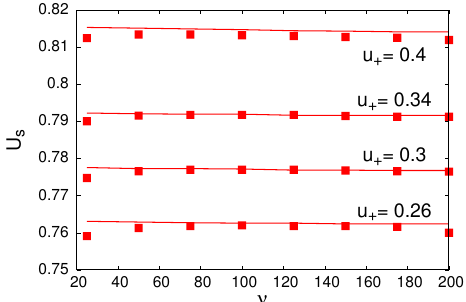
Figure 8. Comparison between the Whitham shock velocity U s given by the modulation equation jump conditions (92)–(93) with (94) and numerical solutions of the nematic Equations (11) and (12) in the TDSW regime. Solution of jump conditions: red (full) line; numerical solution: red boxes. Here, u − = 1.0 and q =